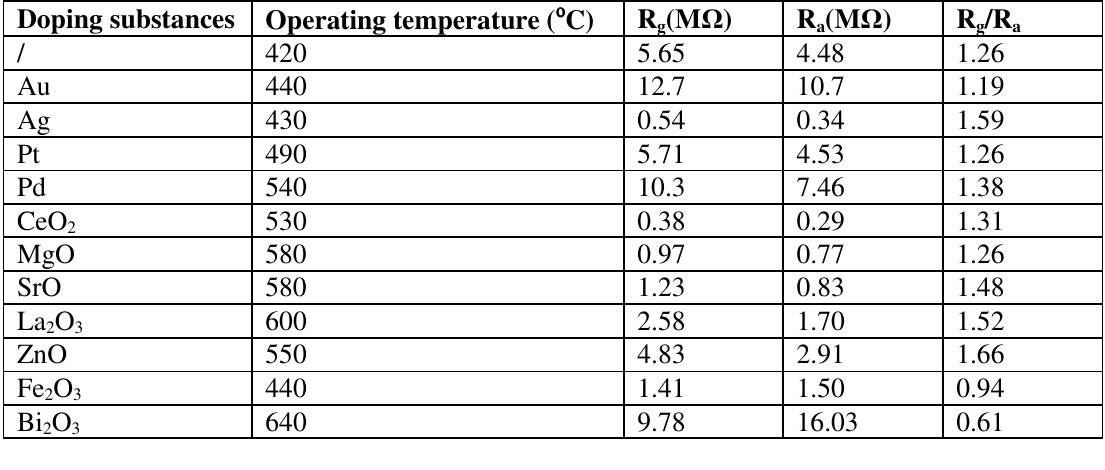
sensitivity of doped CuO-BaTiO 2